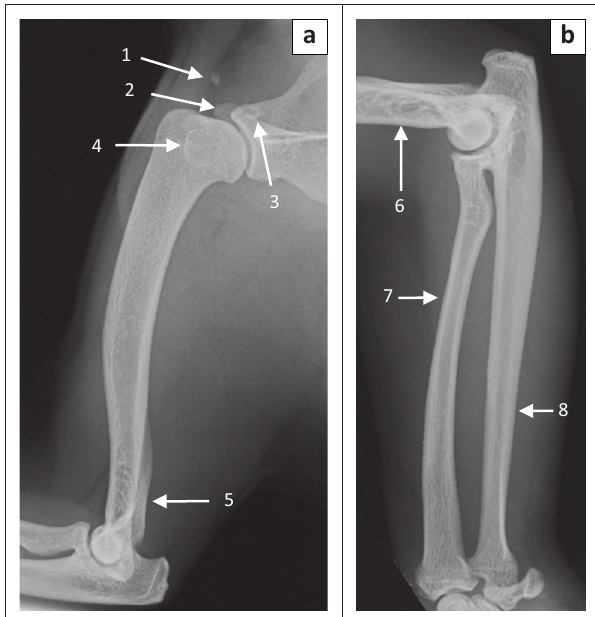
FIGURE 3: Mediolateral radiographs of (a) the right humerus and (b) the radius and ulna of two male red pandas. Bones of a 1.4-year-old animal are shown in (a) and those of a 2.5-year-old animal are shown in